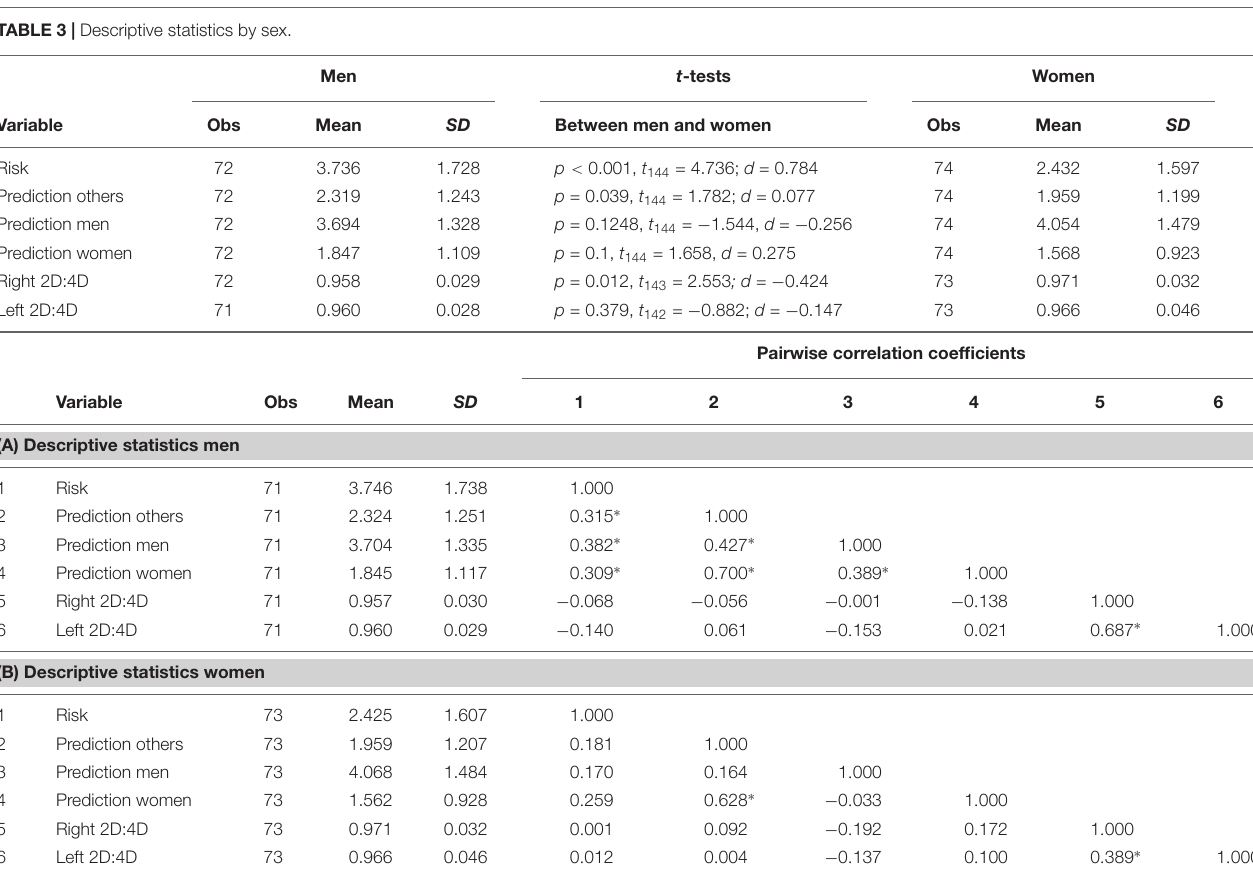
TABLE 3 | Descriptive statistics by